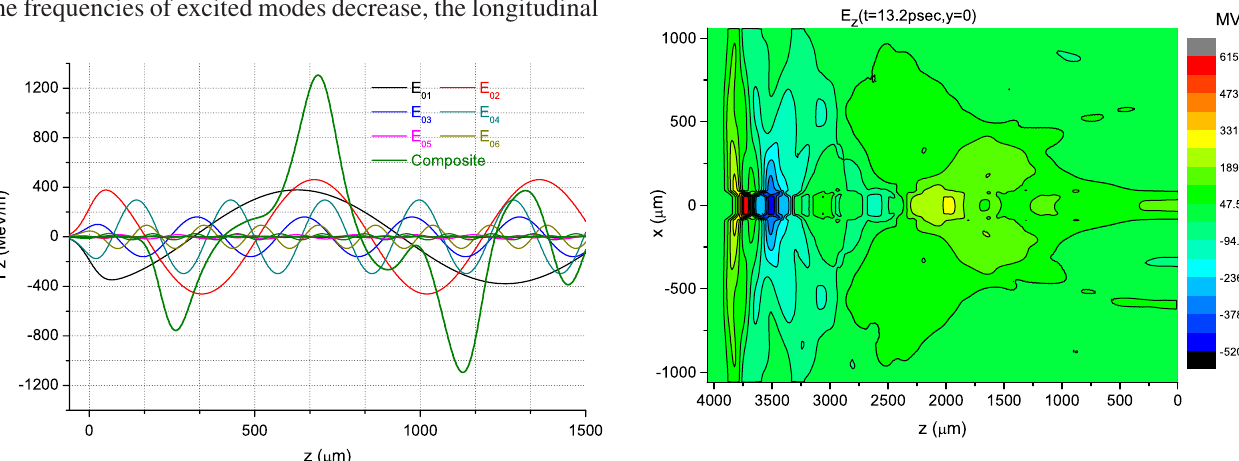
FIG. 15. (Color) Map of the axial wakefield in the coaxial FIG. 14. (Color) Axial profiles of the longitudinal composite DWFA. The origin of the Cartesian coordinate system is at the modes acting on force and components of the force of the E axis ( x ¼ 0 , y ¼ 0 ), at the input end ( z ¼ 0 ) of the structure. The 0 m a test electron along the center of the accelerating channel. The annular bunch drives these fields, and its center is located on the drive bunch moves from right to left and its center is located at far left from the entrance into DWFA at the z ¼ 3880 (cid:1) m . The z ¼ 0 . The dimensions of the dielectric shell and parameters of wakefield pattern moves with the drive bunch, towards the left, the drive bunch are the same as those in Fig. 13. and it has been followed here for t ¼ 13 : 2 psec .